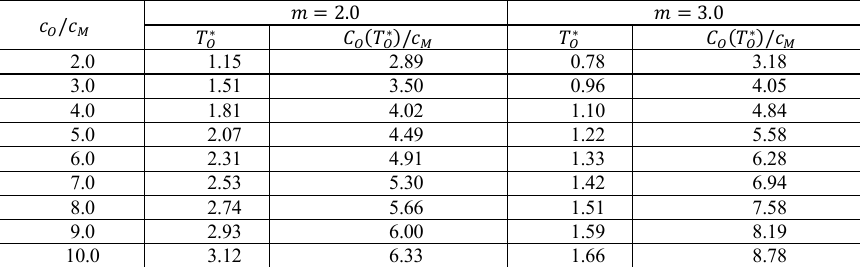
Table 2. Optimum 𝑇 𝑂∗ and its cost rate when 𝐻(𝑡) = 𝑡